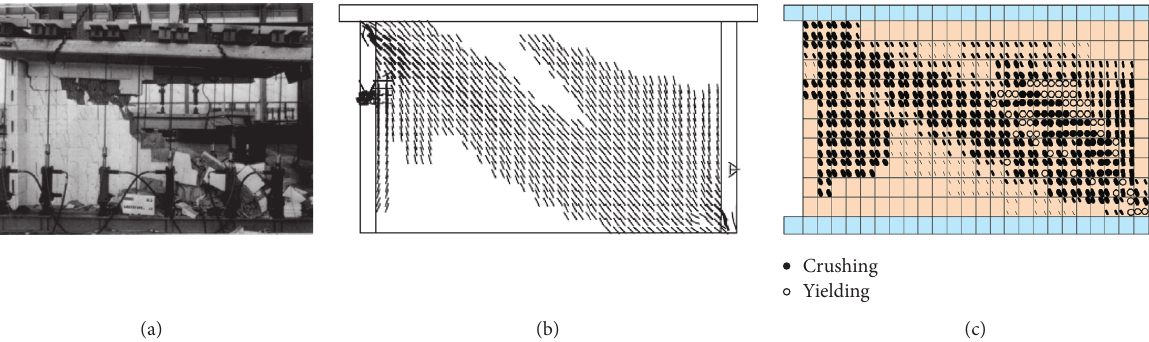
Figure 6: Crack patterns for wall W2 at displacement of 8mm: (a) experiment [27]; (b) numerical results [28]; (c) presented numerical model.